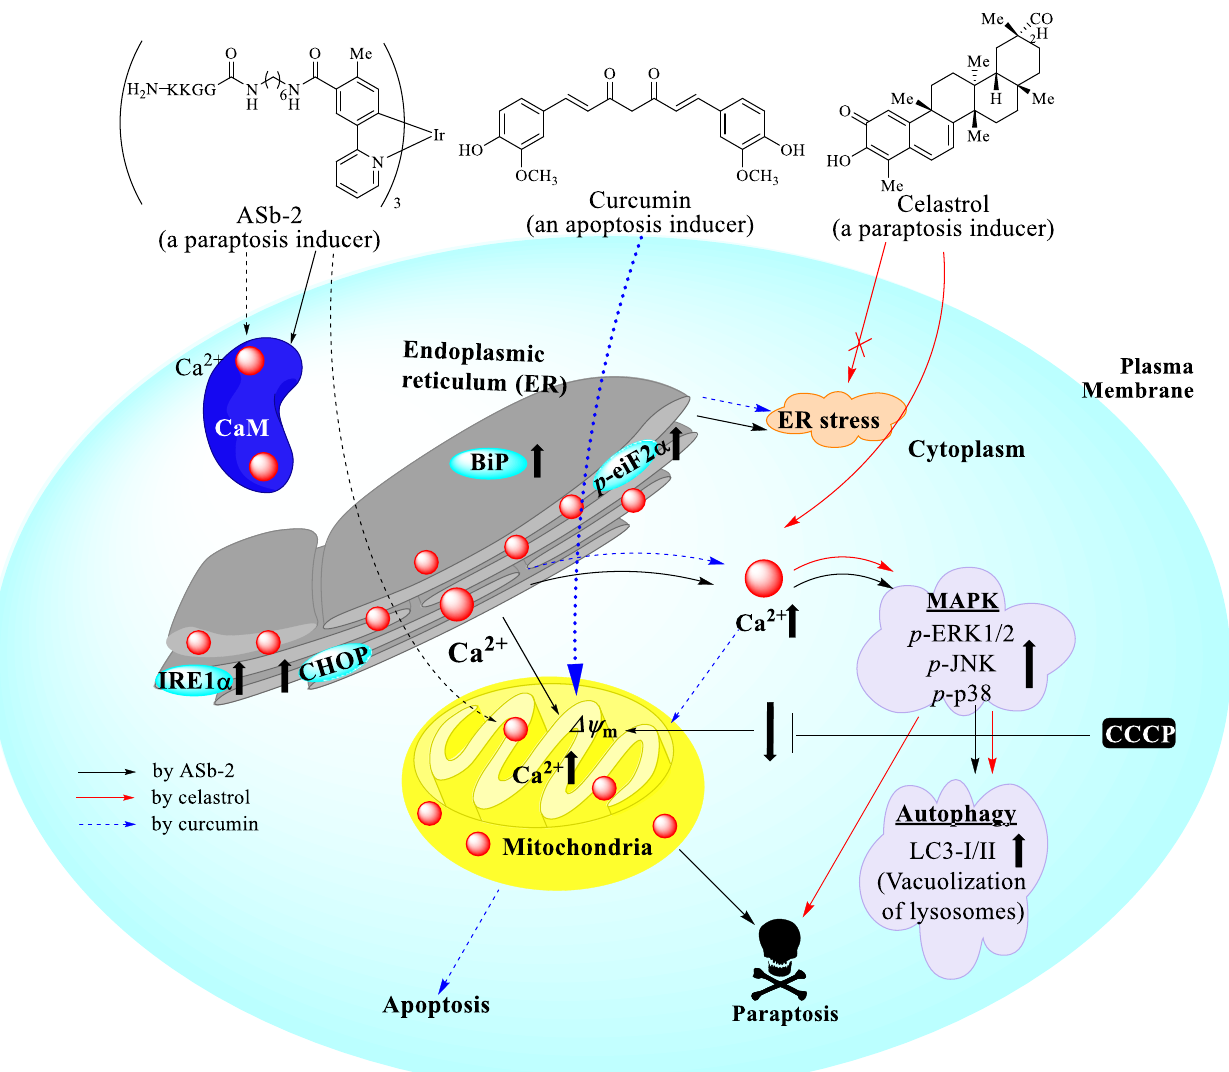
Scheme 1. The proposed mechanism for paraptosis-type programmed cell death induced by ASb-2 (black plain arrows), celastrol (red plain arrows), and curcumin (blue dashed arrows) in Jurkat cells.